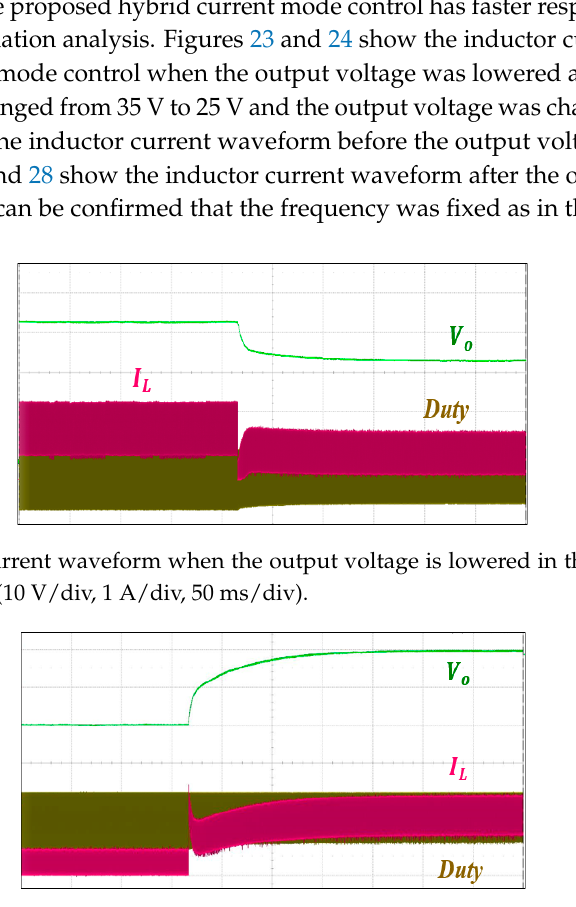
Figure 22. Response time for different controllers. (20 V/div, 400 ms/div).